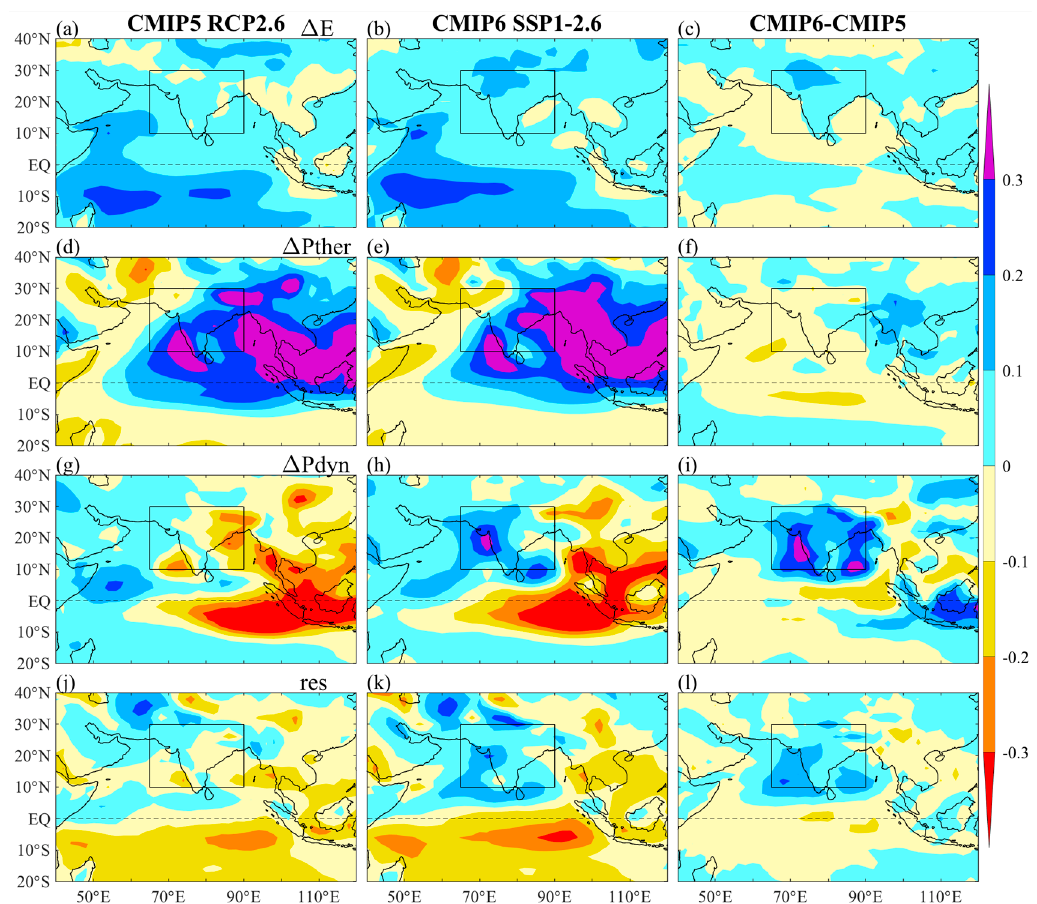
Figure 3. Subcomponents of MME ISM precipitation change (mm day − 1 ): ( a–c ) evaporation change ( ∆ E , mm day − 1 ), ( d–f ) thermodynamical component ( ∆ P ther , mm day − 1 ), ( g–i ) dynamical component ( ∆ P dyn , mm day − 1 ) and ( j–l ) residual term ( 𝑟𝑒𝑠 , mm day − 1 ) under RCP2.6 in CMIP5 and SSP1-2.6 in CMIP6 and their differences.